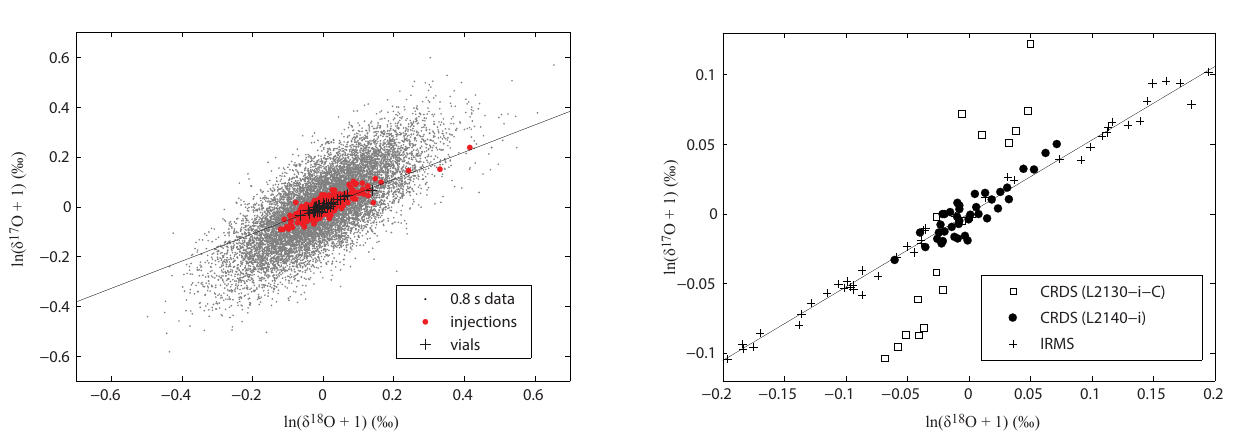
Figure 9. Comparison of the ln (δ 17 O + 1 ) vs. ln (δ 18 O + 1 ) rela- tionship for residuals (difference of individual analyses from the mean) of measurements of water samples with the L2130- i -C and the L2140- i CRDS instruments, and with IRMS. The slope of 0.528 that defines 1 17 O is shown for